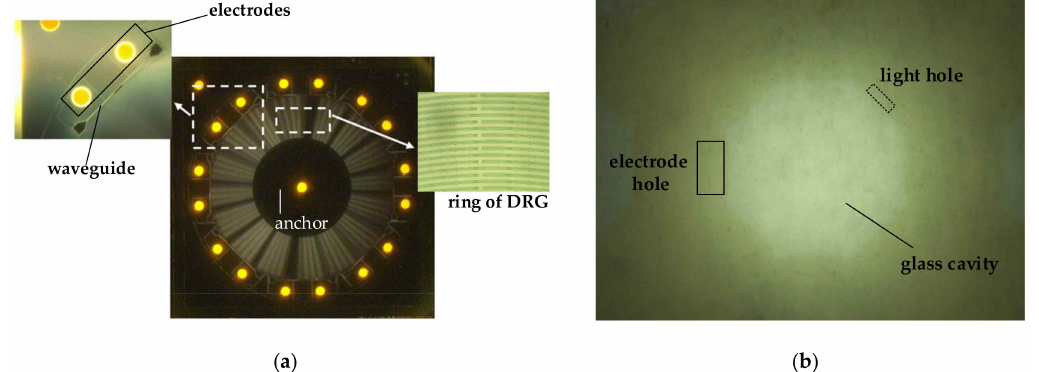
Figure 21. Structure of the MOEMS gyroscope. ( a ) SOI. ( b ) glass.